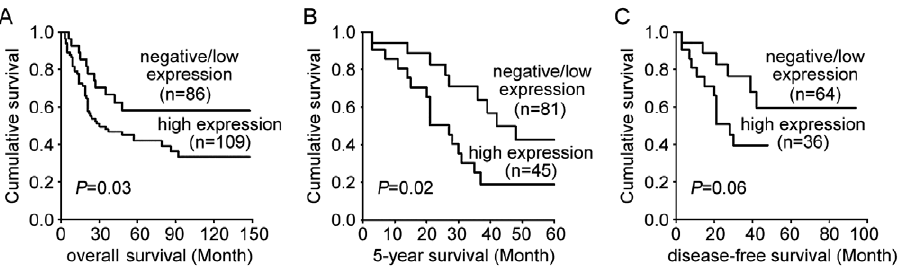
Figure 2. A Kaplan-Meier survival analysis of dyskerin expression in patients with HCC ( log-rank test ) . A. Overall survival of HCC patients: low expression, n=86; high expression, n=109. B. Five-year survival of HCC patients: low expression, n=81; high expression, n=45. C. Disease-free survival of HCC patients: low expression, n=64; high expression, n=36.